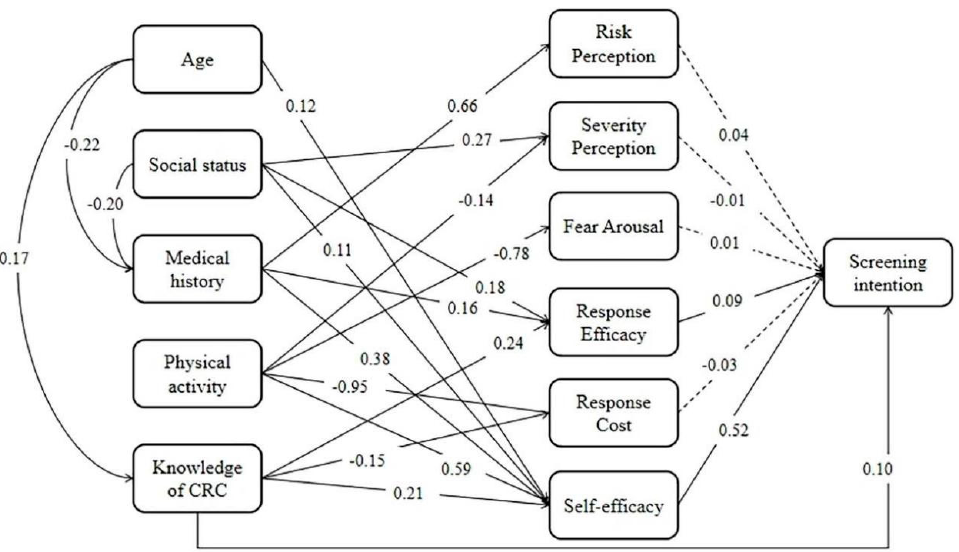
Figure 1. A structure equation modeling factors influencing screening intention. Note: A solid line indicates that the relationship is statistically significant ( p < 0.05), and a dashed line indicates that the relationship had no statistical significance ( p > 0.05). The data − model fit index: GFI = 0.93, AGFI = 0.91, CFI = 0.91, IFI = 0.91, RMSEA = 0.04, Chi − square/df =